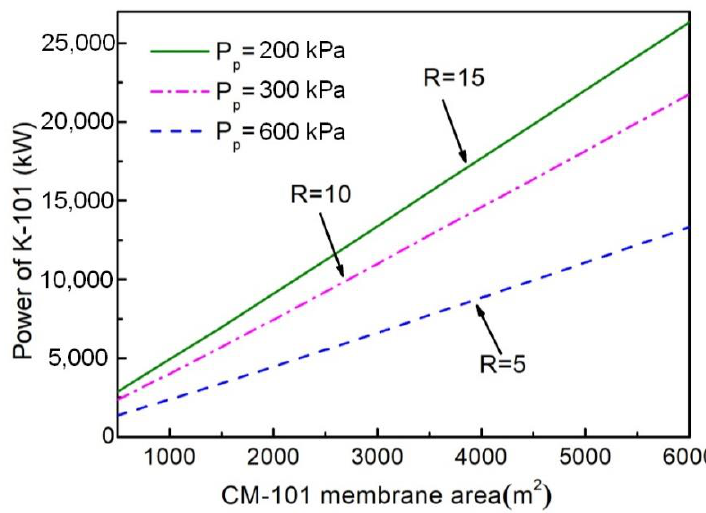
Figure 4. Impacts of CM-101 area on compressor K-101 power under different pressure ratios.